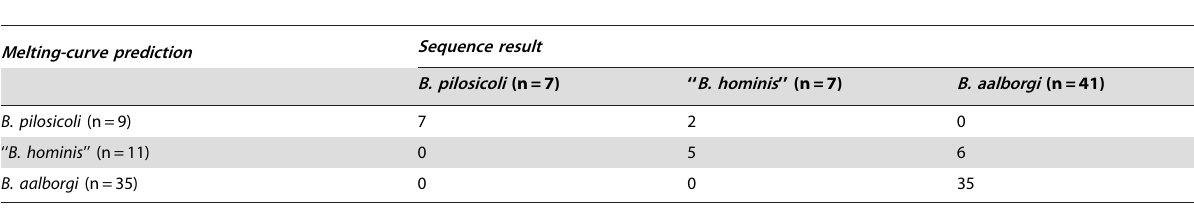
Table 2. Comparison of melting-curve prediction to sequence